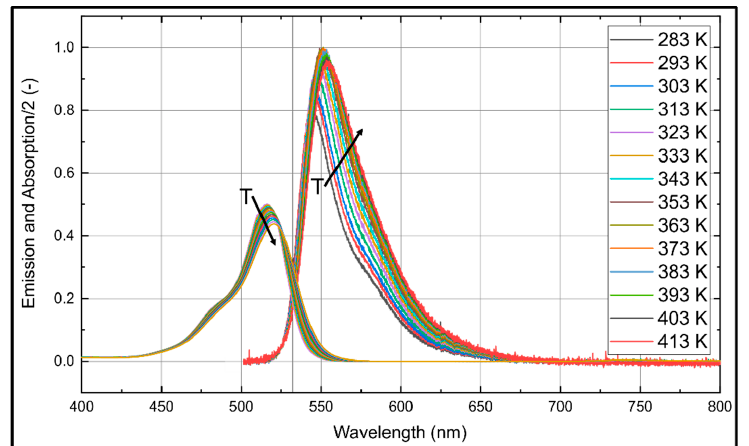
Figure 10. Normalized absorption ( left curves) and emission spectra ( right ) for Eosin-Y (15.86 mg/L) dissolved in water for various temperatures, 0.1 MPa (Please note that the absorption signal is divided by factor of 2 for clarity); the spectra are normalized to the respective maximum peak signal at 283 K (absorption) or 393 K (fluorescence).